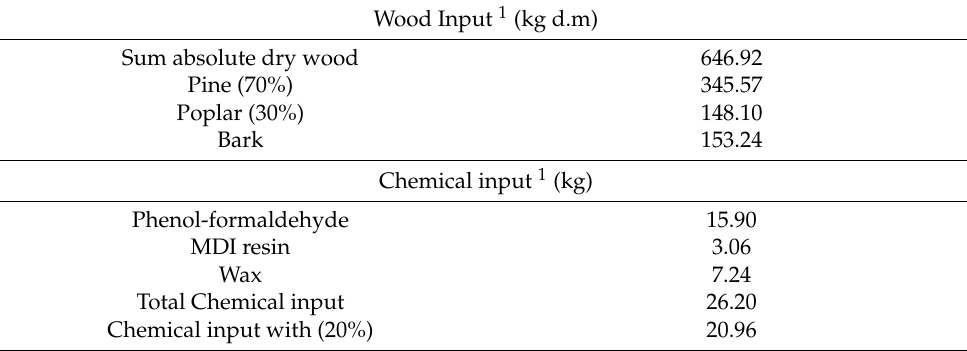
Table 1. Wood input material for 1 m 3 of wood panel (Source: own